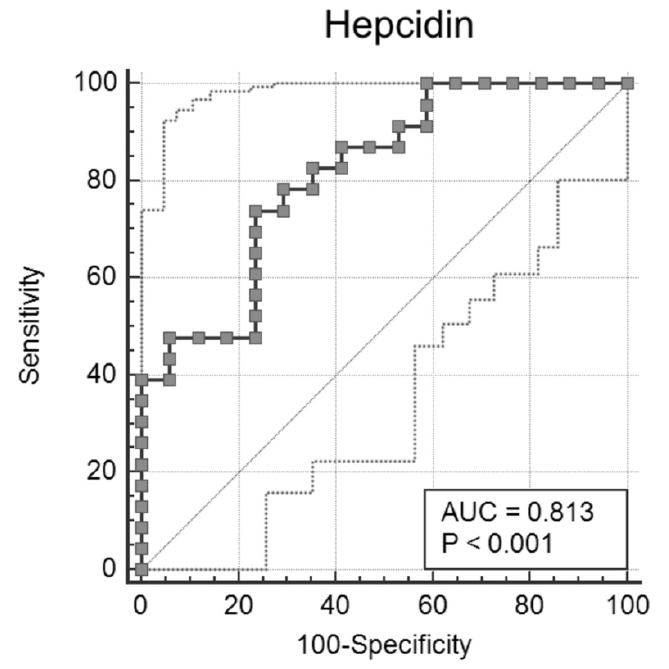
Figure 2. ROC curve analysis of hepcidin in non-survivors’ and survivors’ groups.